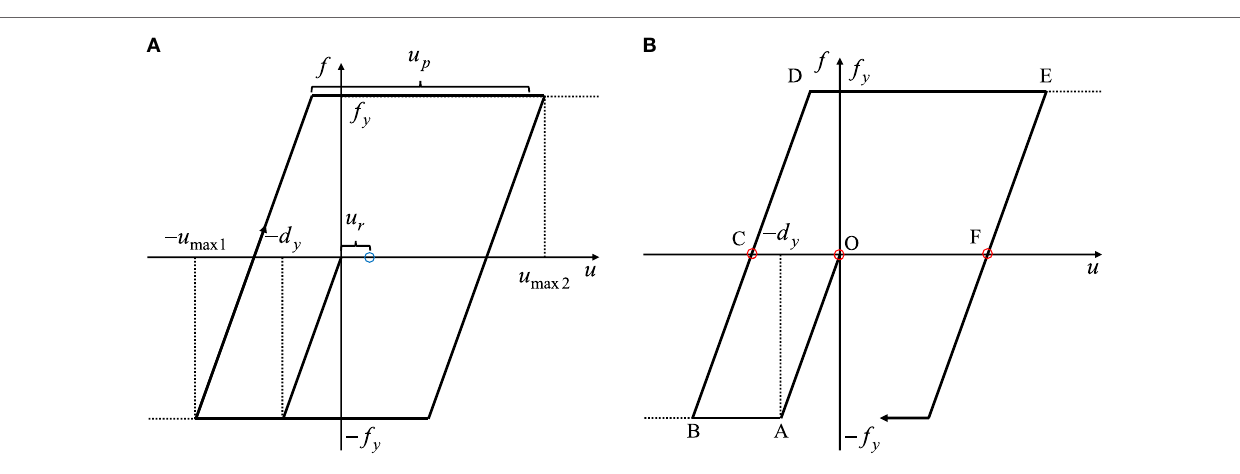
FigUre 4 | Definition of response quantities and response transition: (a) schematic diagram of deformation quantities in force–deformation relation and (B) transition of response process and impulse timing (input sequence 2)